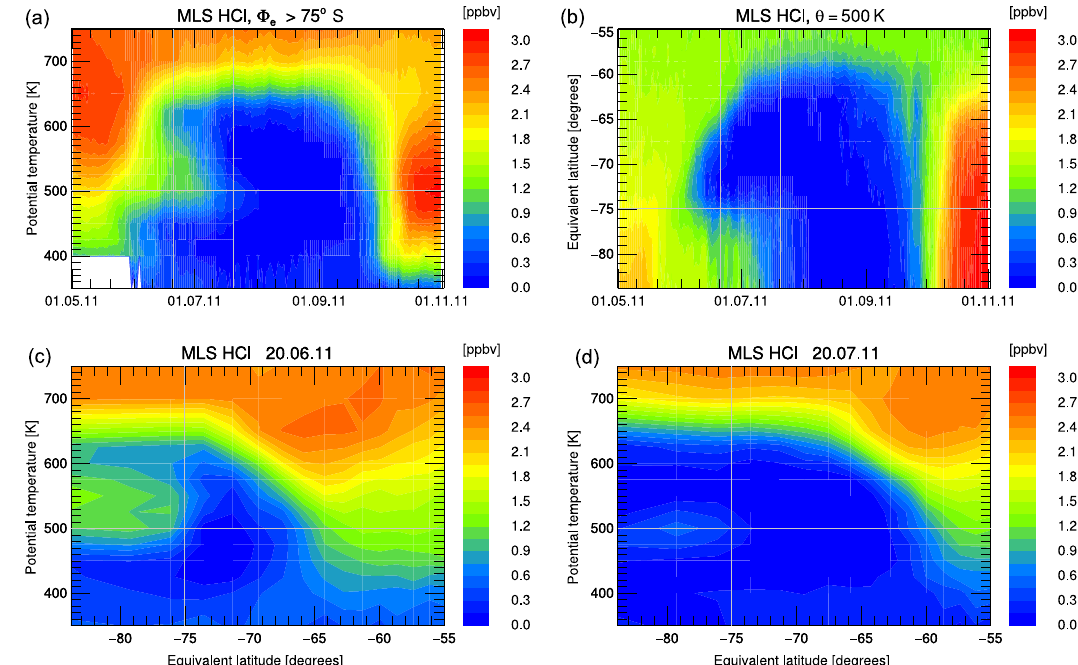
Figure 2. Depiction of MLS HCl mixing ratio data averaged in equivalent latitude/potential temperature space. Panel (a) shows the vortex- core average for equivalent latitudes poleward of 75 ◦ S as a function of time and potential temperature. Panel (b) shows the time development on the 500K potential temperature level. Panels (c, d) show a snapshot of this average on 20 June and 20 July 2011. Grey lines on the panels indicate the cuts or borders displayed in the other panels of this figure.